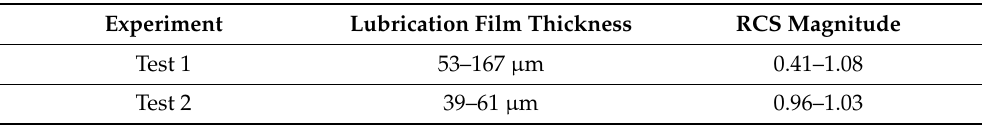
Table 2. Approximate lubrication film thickness and RCS magnitude range for the different experi- ments calculated using manual calibration.